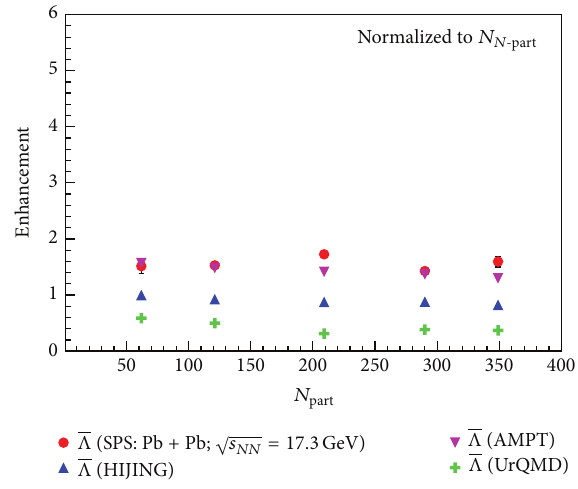
Figure 7: 𝑁 𝑁 -normalized enhancements of Ξ -part collision centrality for Pb + Pb collisions at √𝑠 𝑁𝑁 = 17.3 GeV are compared with HIJING, AMPT, and UrQMD models at midrapid- ity.